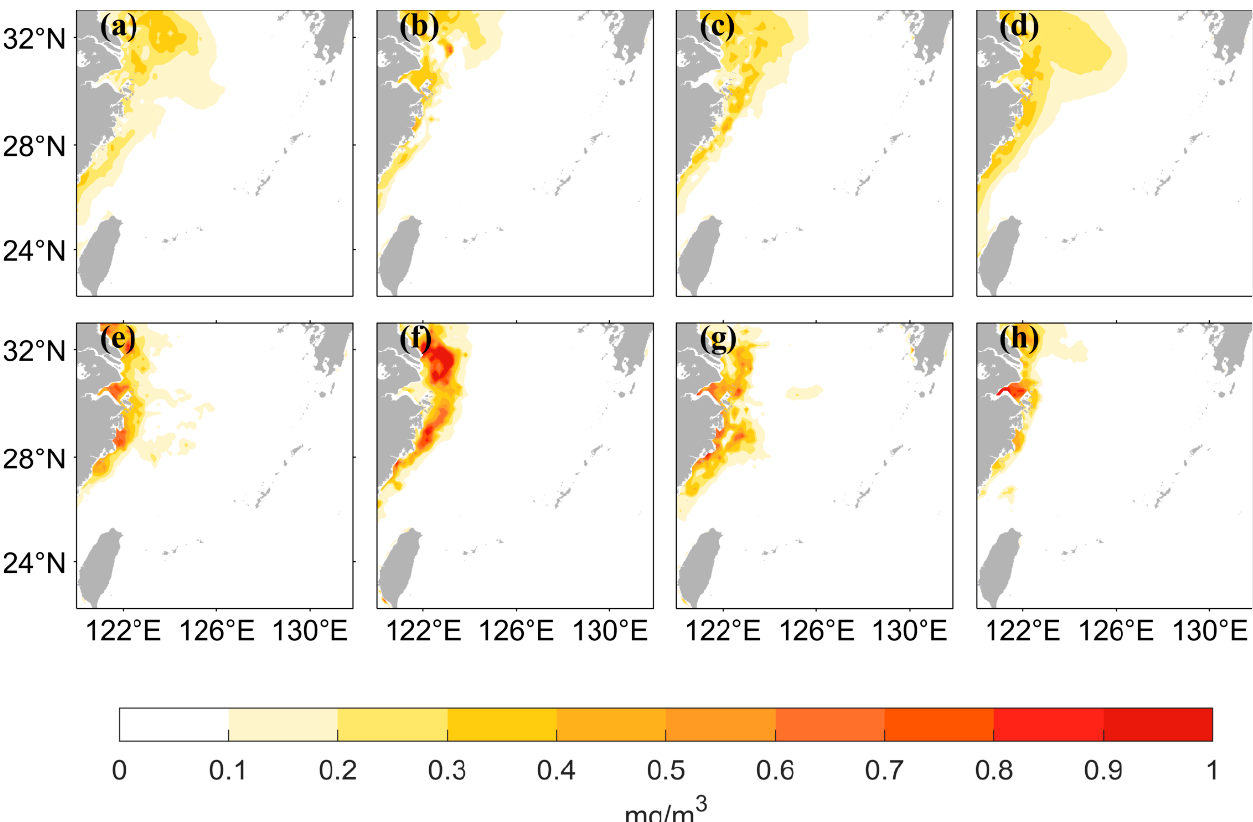
Figure 7. Spatial distribution of 𝐴𝐸 between Chl-a values predicted by two different LSTM models and Chl-a values observed by satellite for four seasons. ( a – d ) represent the distribution of 𝐴𝐸 obtained by LSTM model using the original values as input, in the order of spring, summer, autumn, and winter. ( e – h ) represent the distribution of 𝐴𝐸 obtained by LSTM model using the logarithmic values as input.